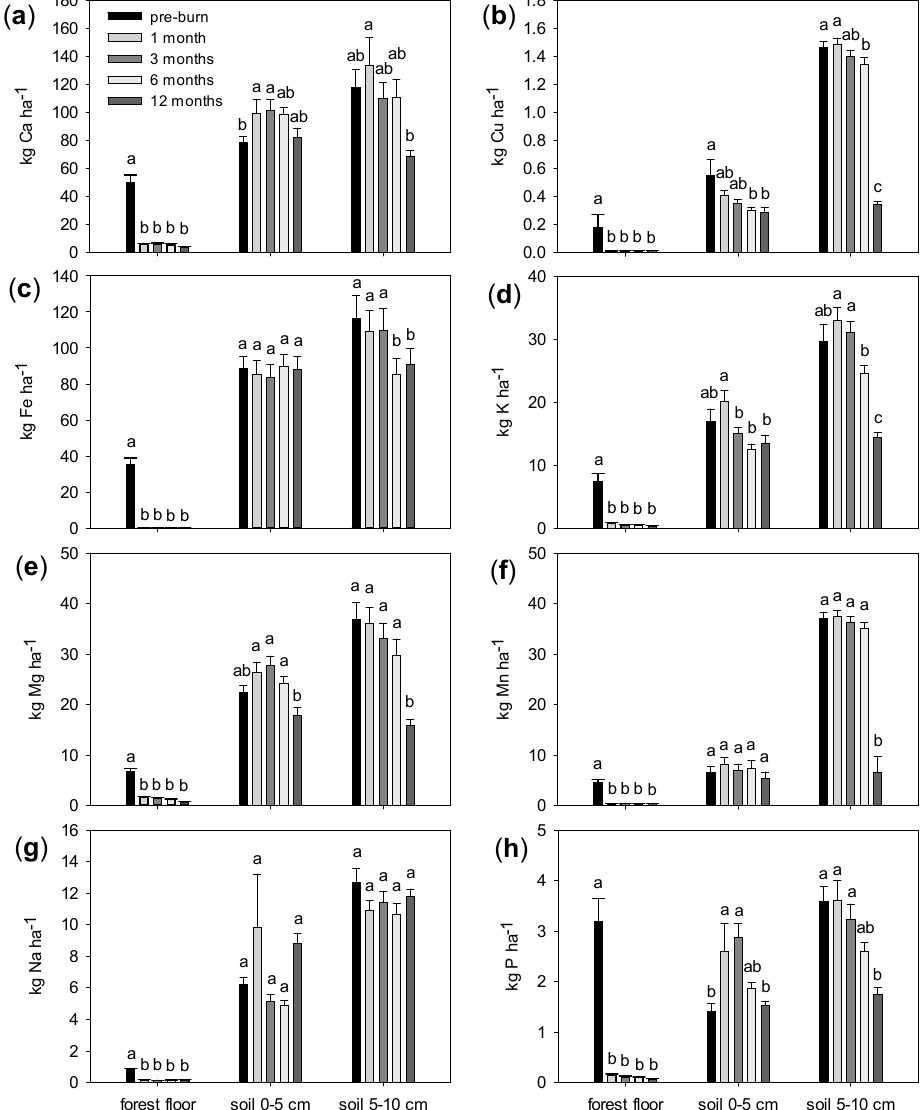
Figure 5. Soil nutrient content of Ca, Cu, Fe, K, Mg, Mn, Na, and P ( a – h ) from samples collected pre-burn, followed by collections 1, 3, 6, and 12 months after the fire. Within each group, means with the same letter do not di ff er at p < 0.05 and error bars represent the standard error of the mean.